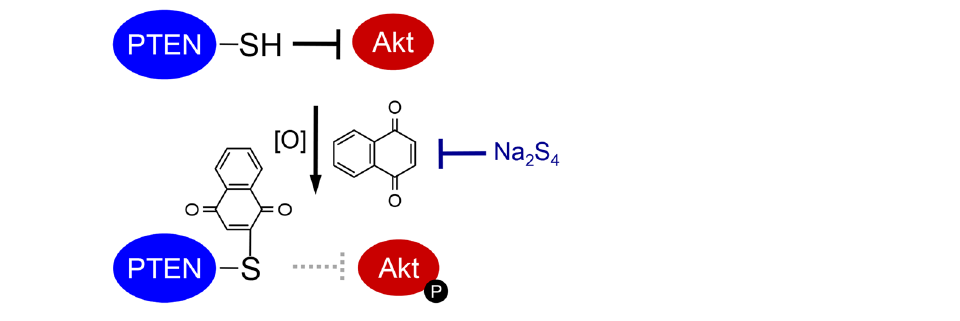
Cys71, but not Cys124, in PTEN 28 . This suggested that the organic electrophile had a preference for Cys71, rather than Cys124, in formation of the electrophile adducts detected by MS/MS.